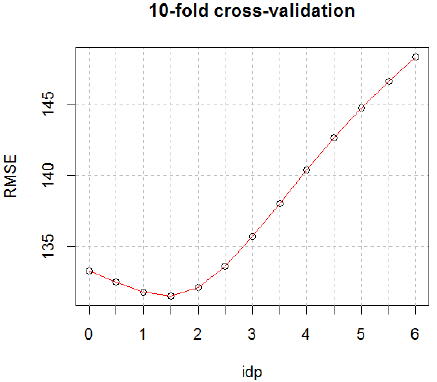
Figure 3. Inverse distance weighting power (idp) optimization.